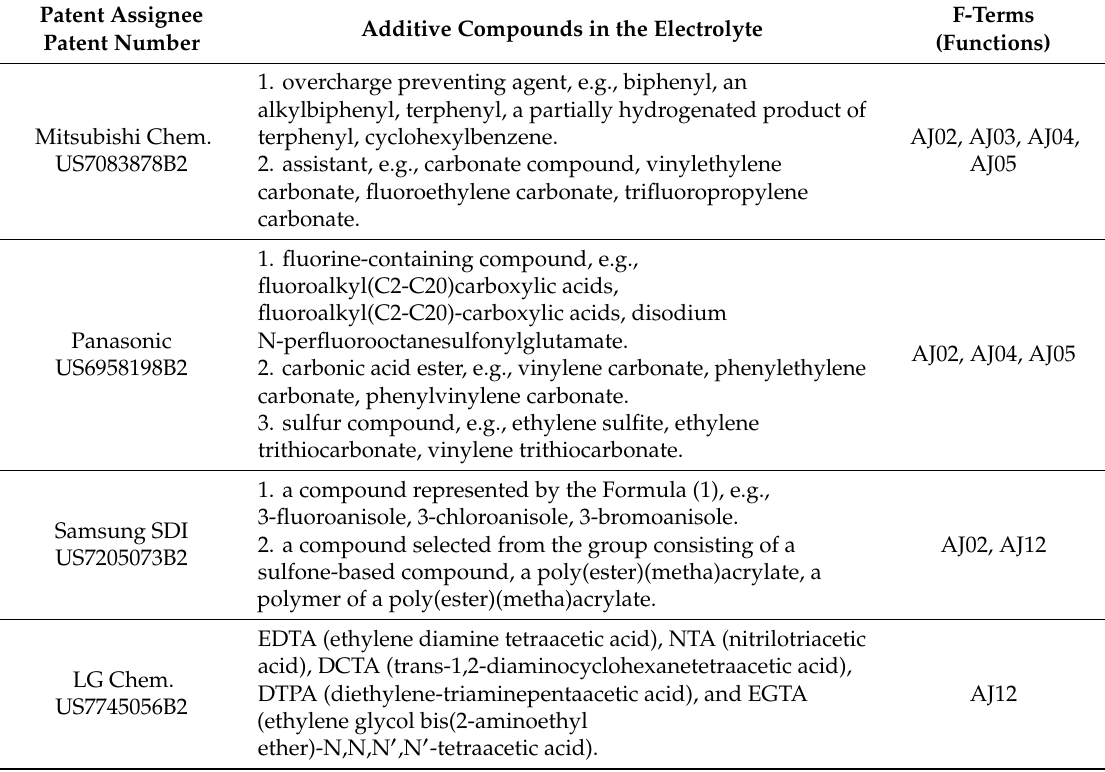
Table 3. Information of representative